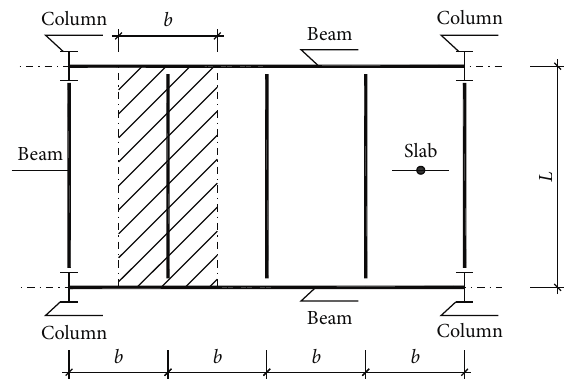
Figure 6: An SCC beam for validation of the proposed algorithm. Table 3: Input parameters of the SCC beam for validating the proposed algorithm.